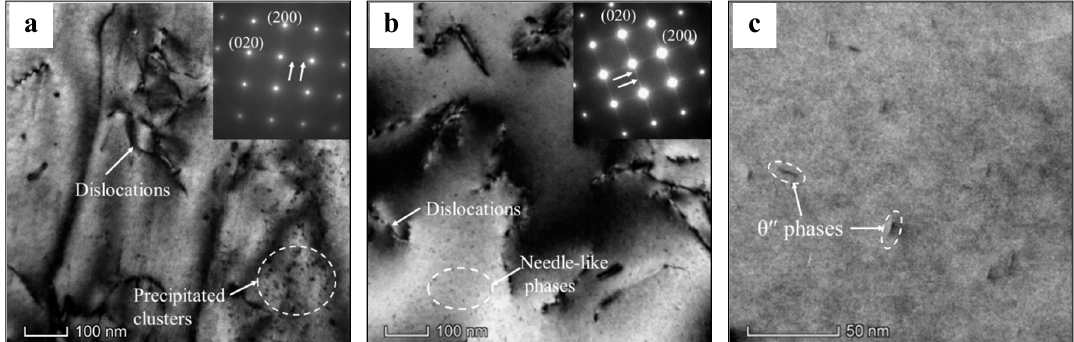
Figure 8. TEM images and selected area electron diffraction (SAED) patterns of the alloy heated to target temperatures of ( a ) 150 °C, and ( b , c ) 250 °C.